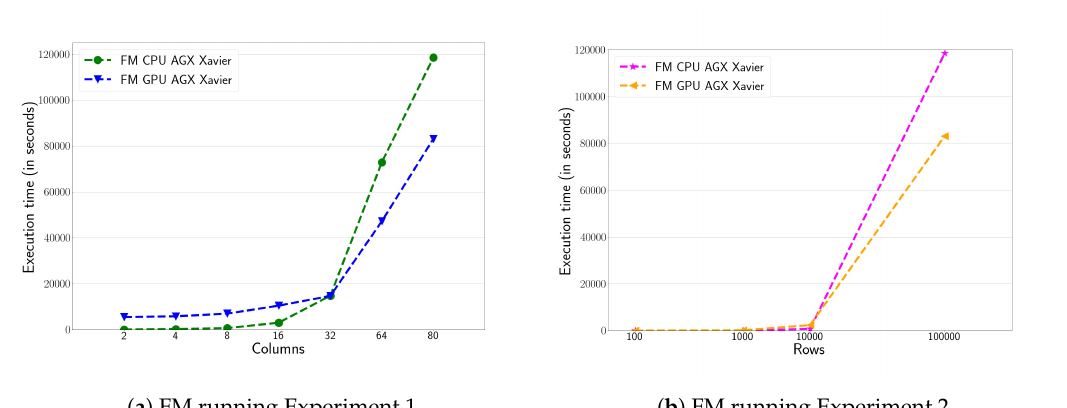
Figure 5. Execution time (in seconds) for Experiment 1 and 2 for the FM algorithm on the NVIDIA AGX Xavier.